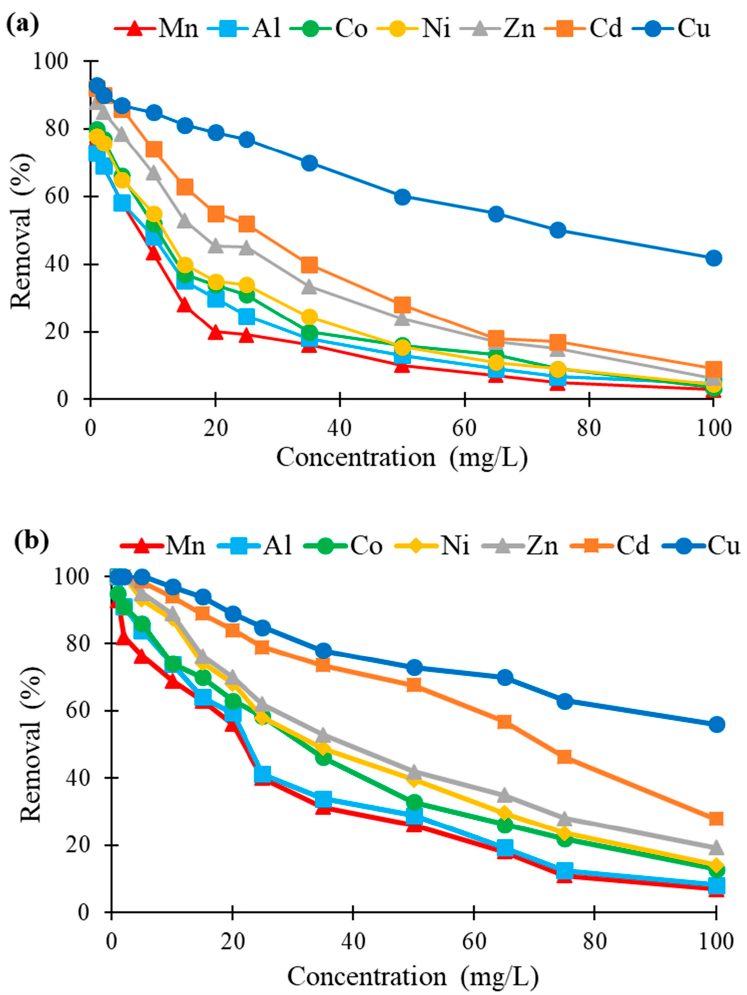
Figure 3. Effect of initial concentration (in mg/L) of seven metals (expressed in %) on their removal by ( a ) hemp- and ( b ) flax-based felts (other conditions: 1 g of felt in 100 mL of solution; contact time, 60 min; agitation speed, 250 rpm; temperature, 22 ± 1 °C; n = 3).